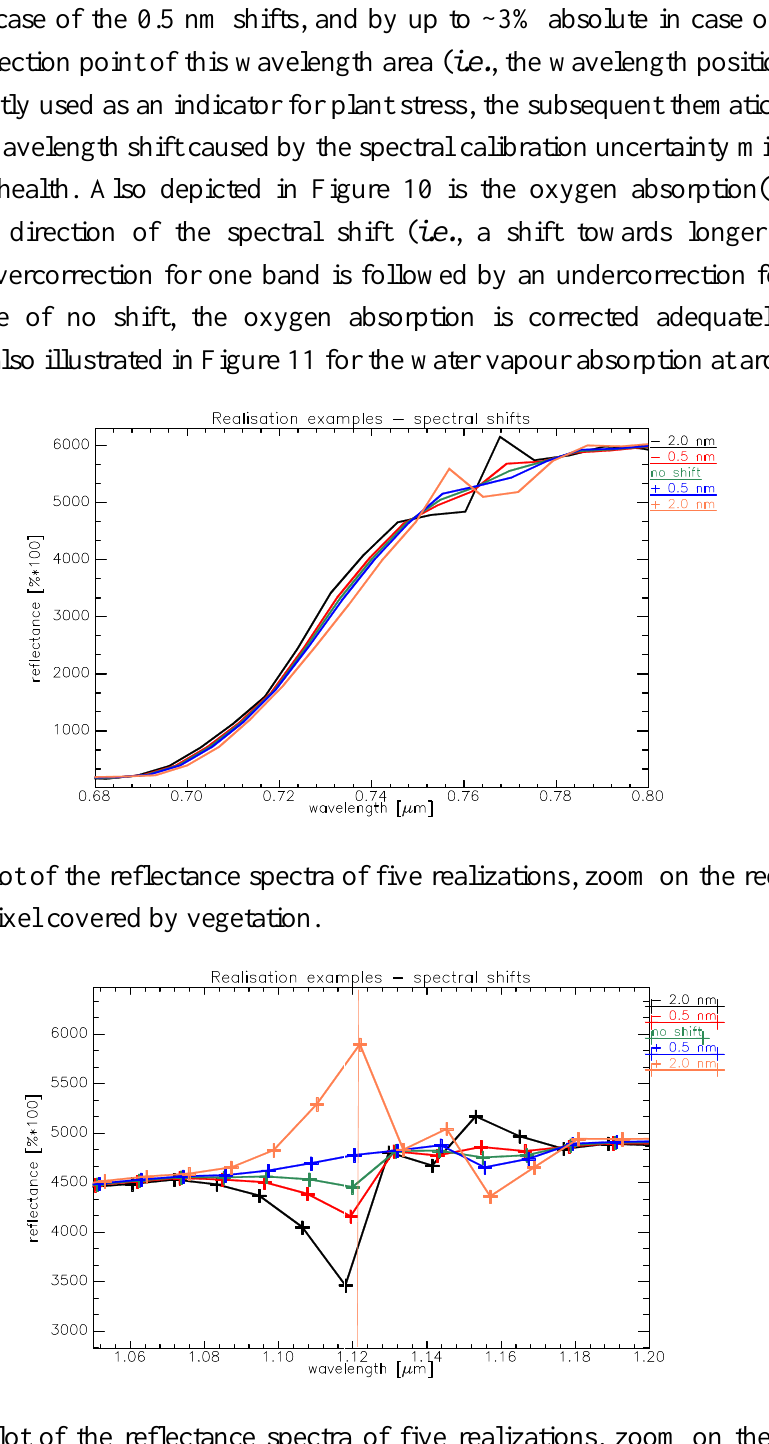
Figure 11. Plot of the reflectance spectra of five realizations, zoom on the minor water vapour absorption feature at 1130 nm. The vertical black and orange lines illustrate the magnitude of the shift of −2.0 nm up to +2.0